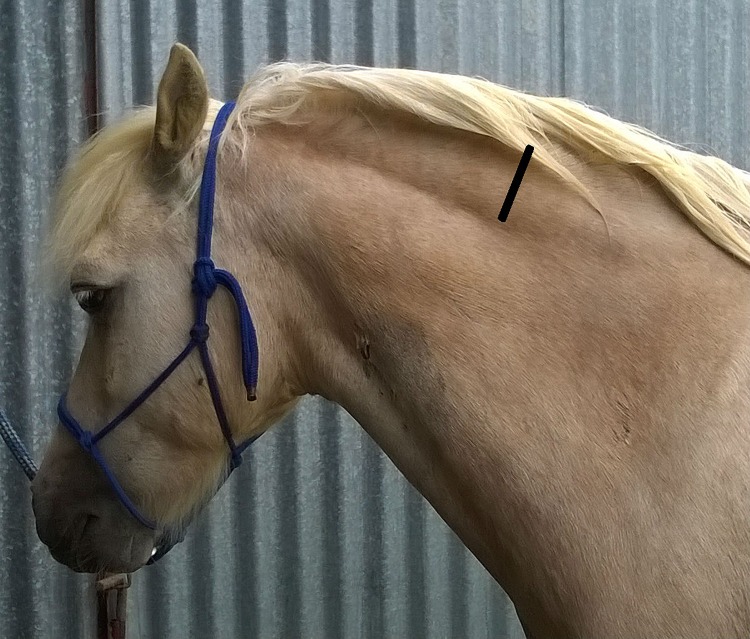
A pony with a cresty neck.A crest neck is an enlarged fat deposit along the nuchal ligament, identified by the black bar. This pony was assigned a cresty neck score of 3.